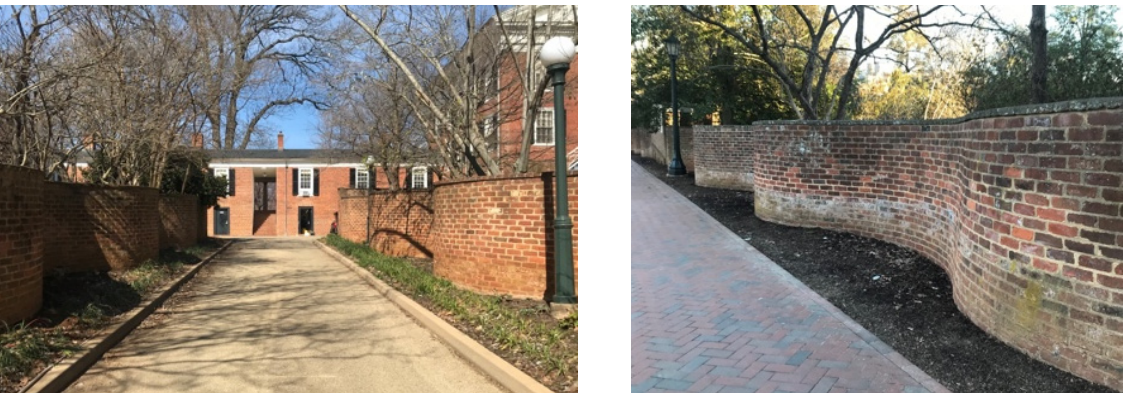
Figure 5. Serpentine walls designed by Thomas Jefferson and built by slave labor that enclose the gardens at the rear of the residences of the historical academical village at the University of Virginia located in Charlottesville, VA, USA. Photos by the author.